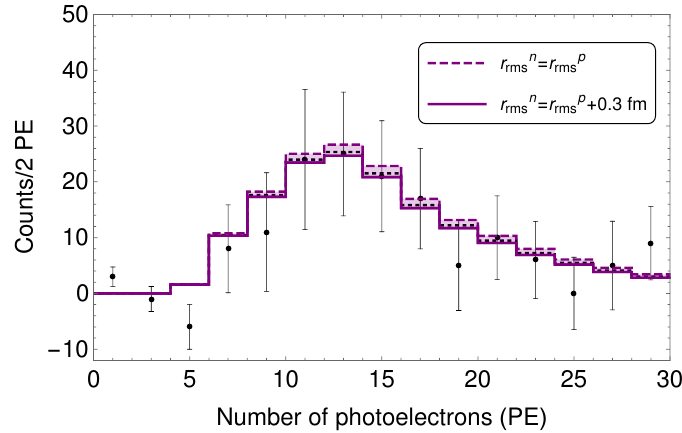
Figure 2 . The expected CE (cid:23) NS residual event spectrum in COHERENT as a function of the number of photoelectrons as predicted in the SM. The points correspond to COHERENT data (with their error bars) [1], while the shaded region between the two histograms de(cid:12)nes the uncertainty in the spectrum due to the form factor uncertainties. The black-dotted histogram is obtained by (cid:12)xing the rms radii of the 133 Cs and 127 I neutron density distributions to values obtained from theoretical calculations; see eq. (4.4). For the dashed histogram, r n table 1. The Helm form factor has been used but a di(cid:11)erent form factor does not noticeably alter the